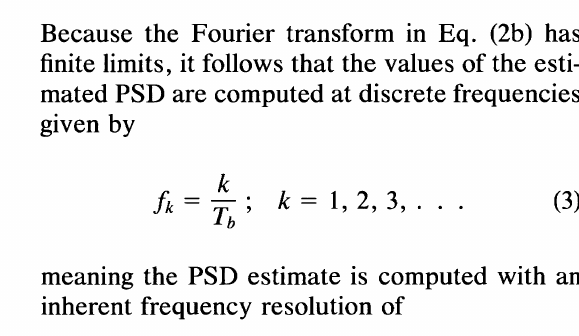
FIGURE 1 Direct frequency domain filtering procedures for PSD